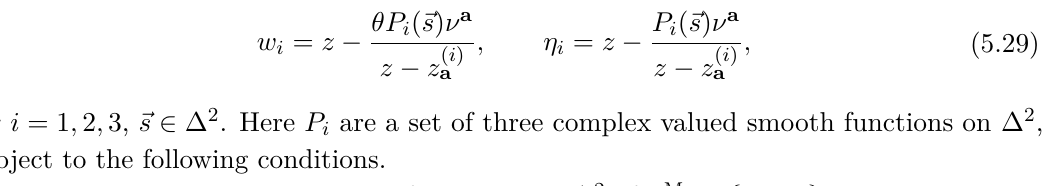
Figure 2 . An example of a construction of a homotopy between Γ α specific choice of Γ xy using a square move and two triangle